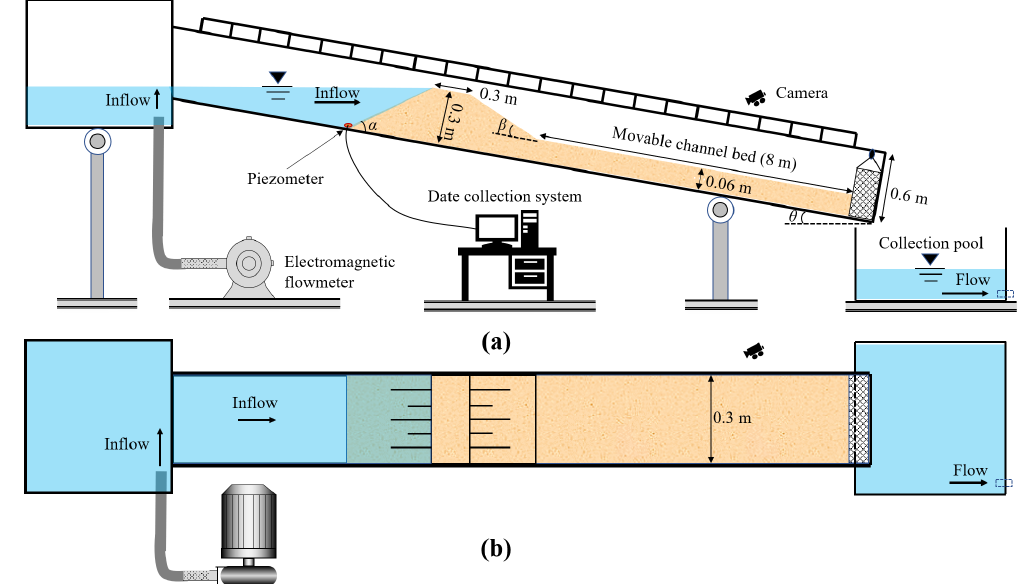
Figure 2. Experimental setups. (a) Front view of the flume. (b) Top view of the